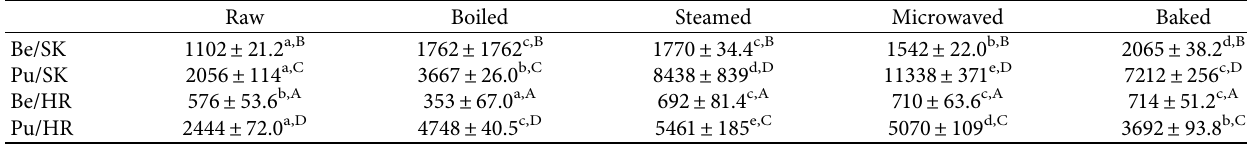
Table 2: The total polyphenols content (mg GAE/kg